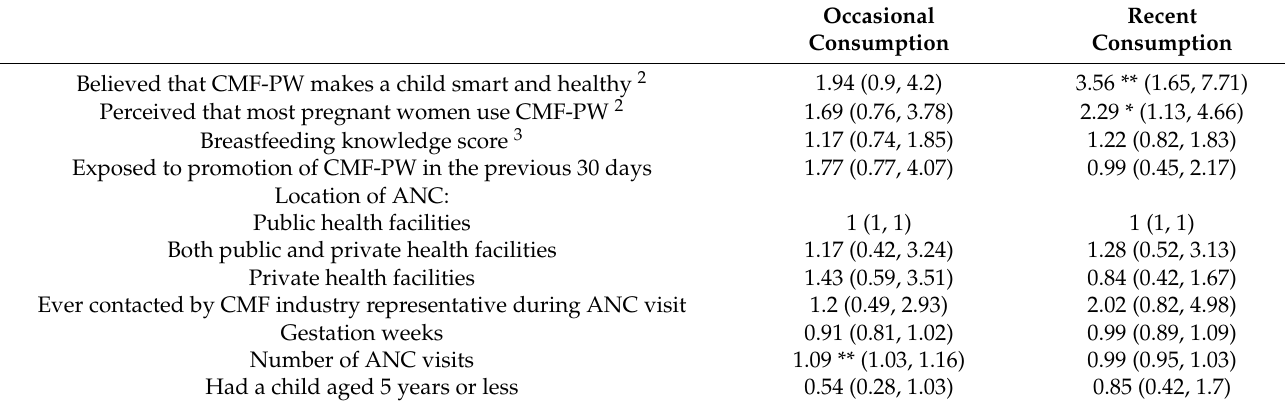
Table 4. Adjusted odds ratios (aOR) and 95% confidence intervals (95% CI) for associated factors of using commercial milk formula for pregnant women (CMF-PW, n = 268) 1